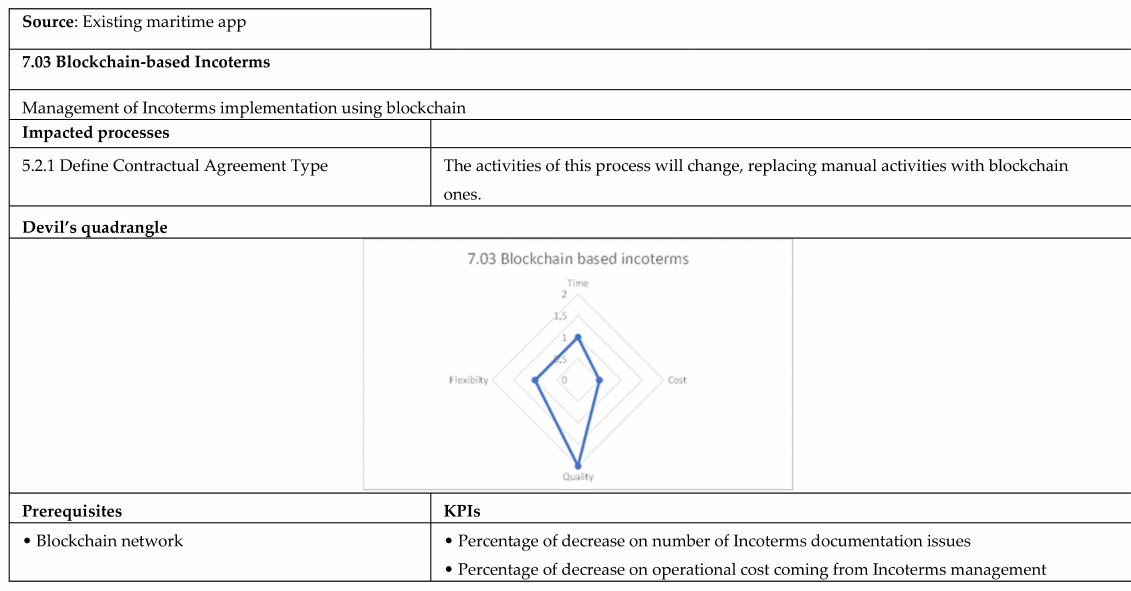
Figure A44. Blockchain-based Incoterms data sheet.